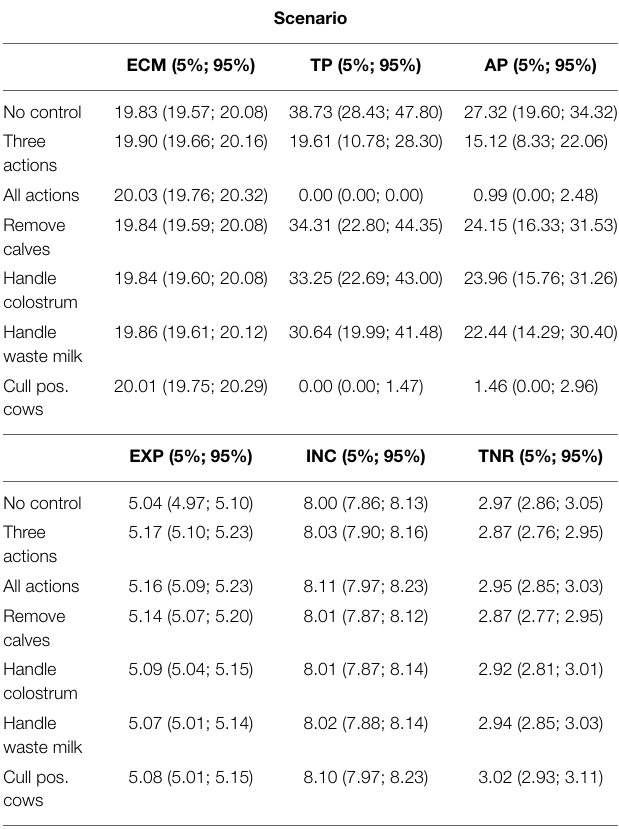
TABLE 1 | Results of the scenarios on an average-hygiene herd with a TABLE 2 | Results of the scenarios on a low-hygiene herd with a baseline baseline true within-herd prevalence of 5.6% . true within-herd prevalence of 45% . Scenario